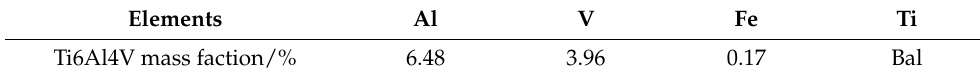
Table 2. Mass percentage of main elements in Ti6Al4V alloy powder.